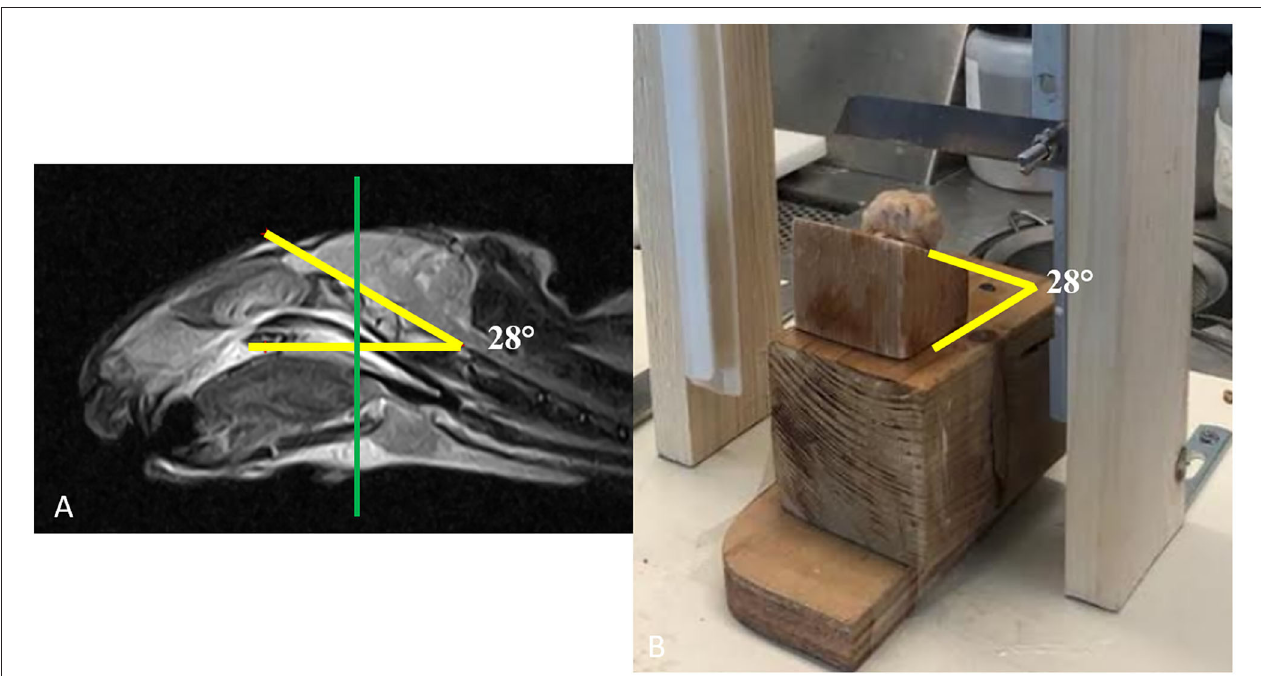
FIGURE 1 | Operative procedure for brain cuts. (A) The inclination of the brain obtained from the T2w sagittal images and (B) the same inclination as in (A) has been reproduced with wooden wedges to be used with a small cutting tool specifically prepared for the experiment.